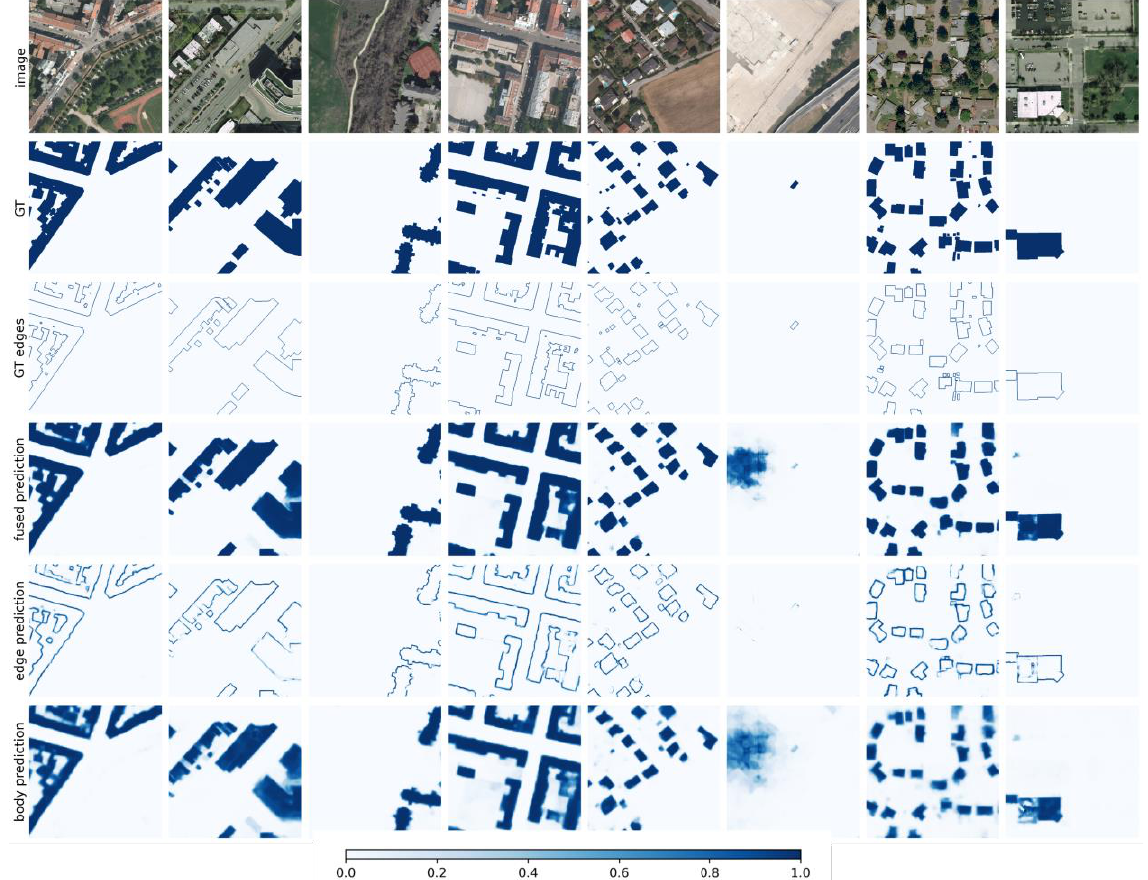
Figure 5. Random image samples together with the ground truth building footprints (row 2) and building boundaries (row 3) as well as the proposed model